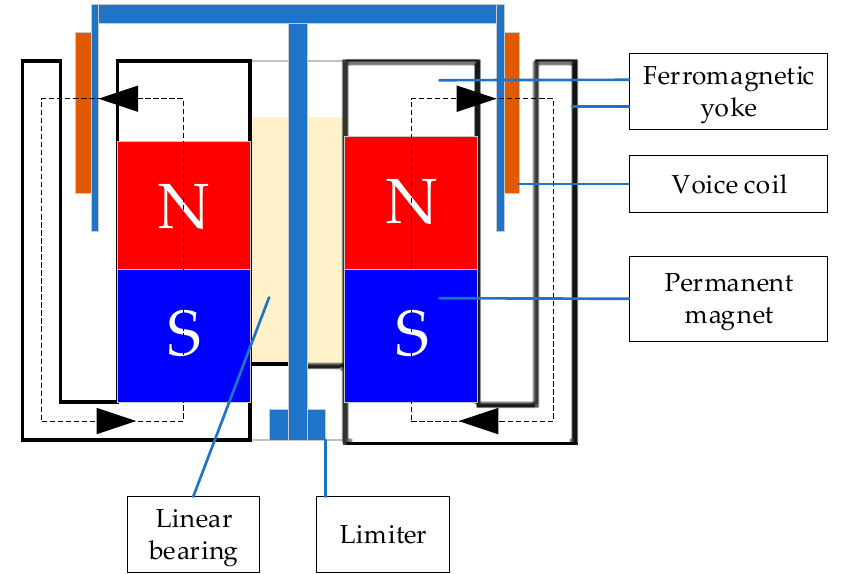
Figure 2. Cross-sectional diagram of the maglev actuator.